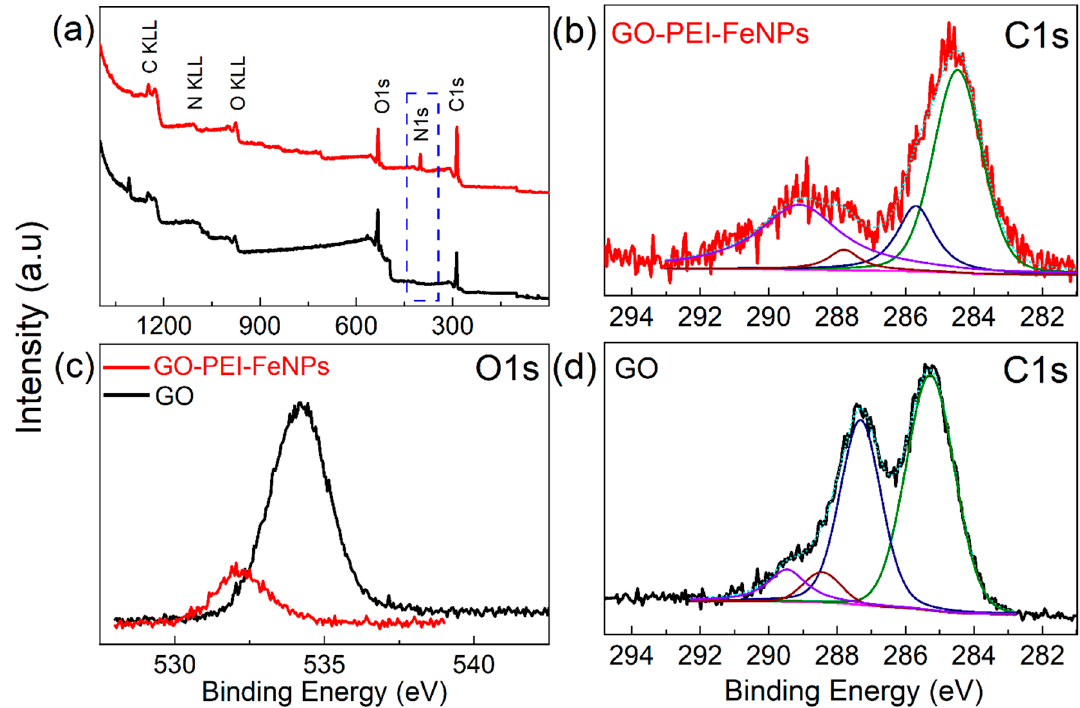
Figure 3. XPS of survey spectrums of the GO and GO–PEI–FeNPs foams ( a ). High-resolution spectrums of C1s ( b , d ) and O1s before and after functionalization with PEI ( c ).